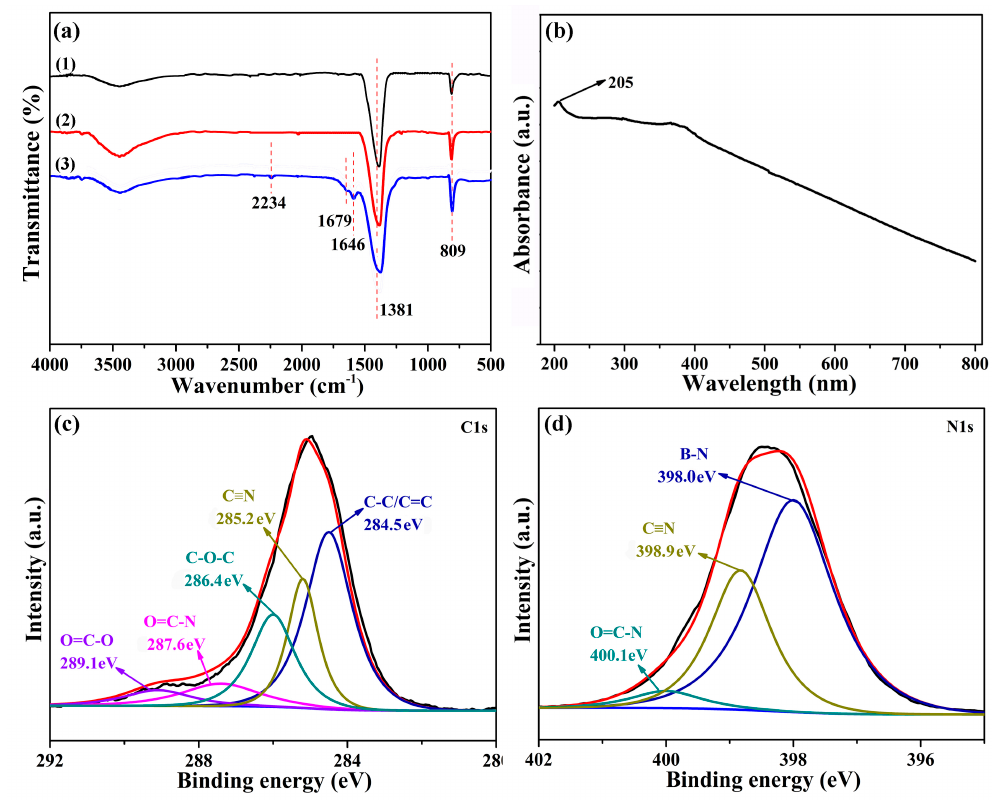
Figure 2. ( a ) FT-IR spectrum; ( b ) UV-Vis absorption spectrum; ( c ) X-ray photoelectron spectroscopy (XPS) C1s spectrum and ( d ) XPS N1s spectrum of BN-CN.